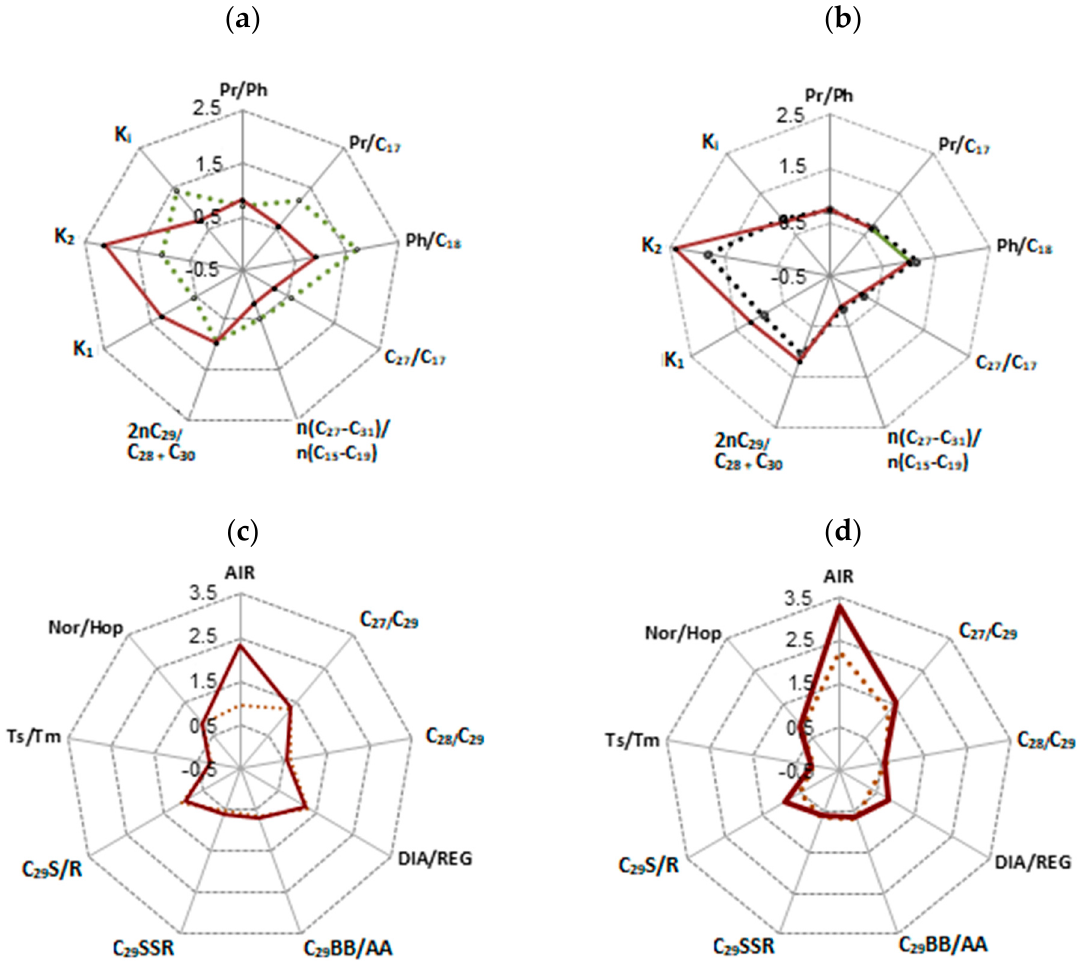
Figure 3. Geochemical parameters of saturated fractions of the rocks from Zelenogorskaya and Berezovskaya areas before and after hydrothermal experiments: ( a , b ) alkanes; ( c , d ) steranes and hopanes, arylisoprenoids. AIR = (C 13 –C 17 )/(C 18 –C 22 ); К 1 = (C 12 –C 14 )/(C 14 –C 15 ); К 2 = (C 14 –C 19 )/(C 19 –C 23 ); K i = ( Π + φ )/(C 17 + C 18 ); T S /T M = C 27 18 α Трисноргоп a н (T S )/C 27 17 α Трисноргоп a н ( Т m ); DIA/REG = C 27 20S βα Ди a стер a н /C 29 20R ααα C тер a н : C 29 S/R = C 29 20S ααα C тер a н /20R ααα C тер a н : C αββ C тер a н /C ααα C тер a н : C ααα - sterane/C ααα -sterane 29 BB/AA = C 29 20R 29 20R 29 SSR =C 29 20S 29 20S + C 29 20R ααα